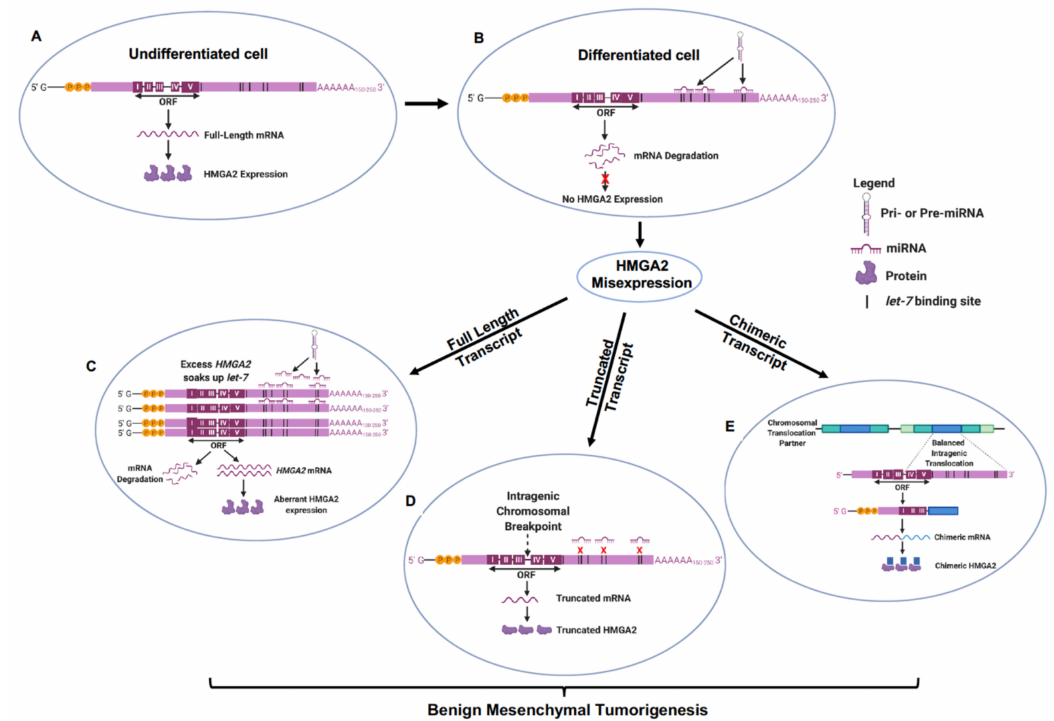
Figure 1. let-7 regulatory mechanisms govern HMGA2 misexpression, driving benign